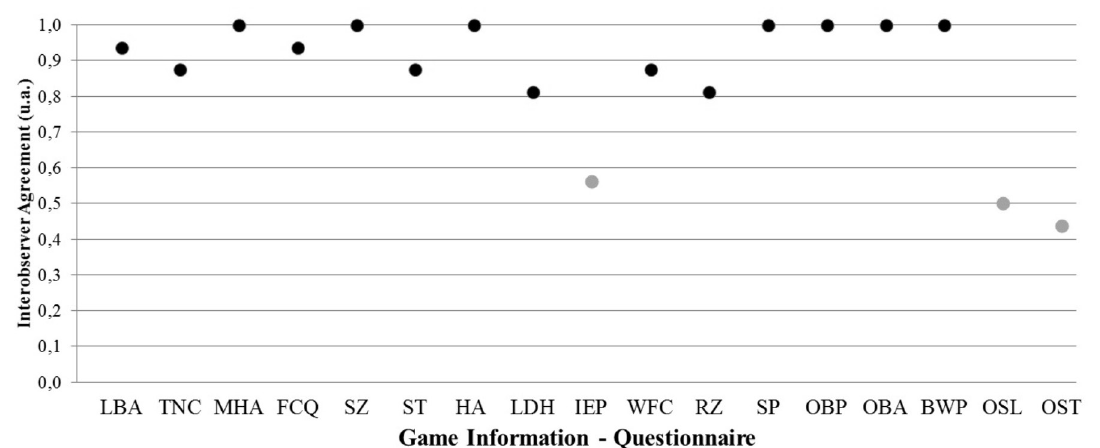
Figure 1: Interobserver Agreement values of each of the game information encountered by the setters during the Attack Processes, contained in the